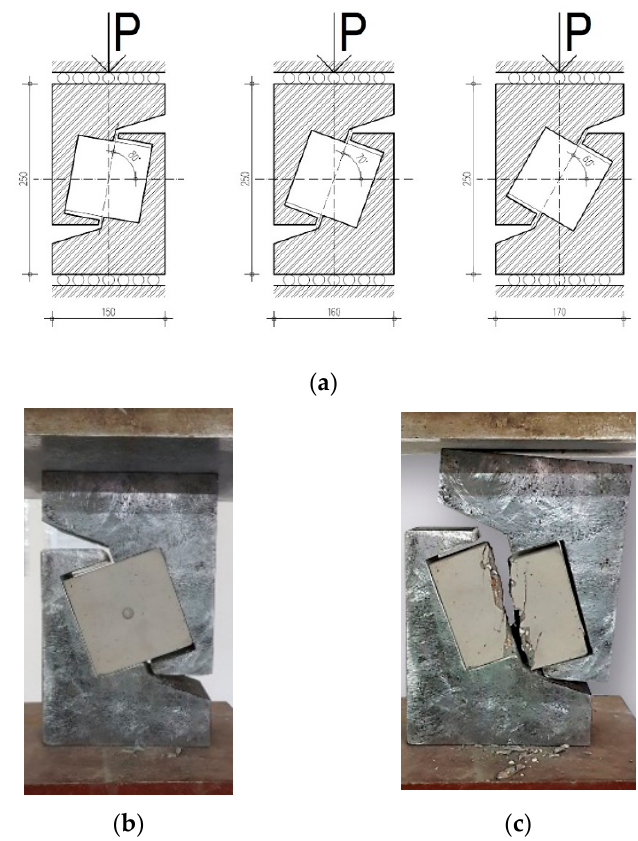
Figure 3. Experimental setup for shear strength testing: ( a ) schematic drawings of mould; ( b ) photo of experimental setup in the laboratory; ( c ) photo of failed sample.